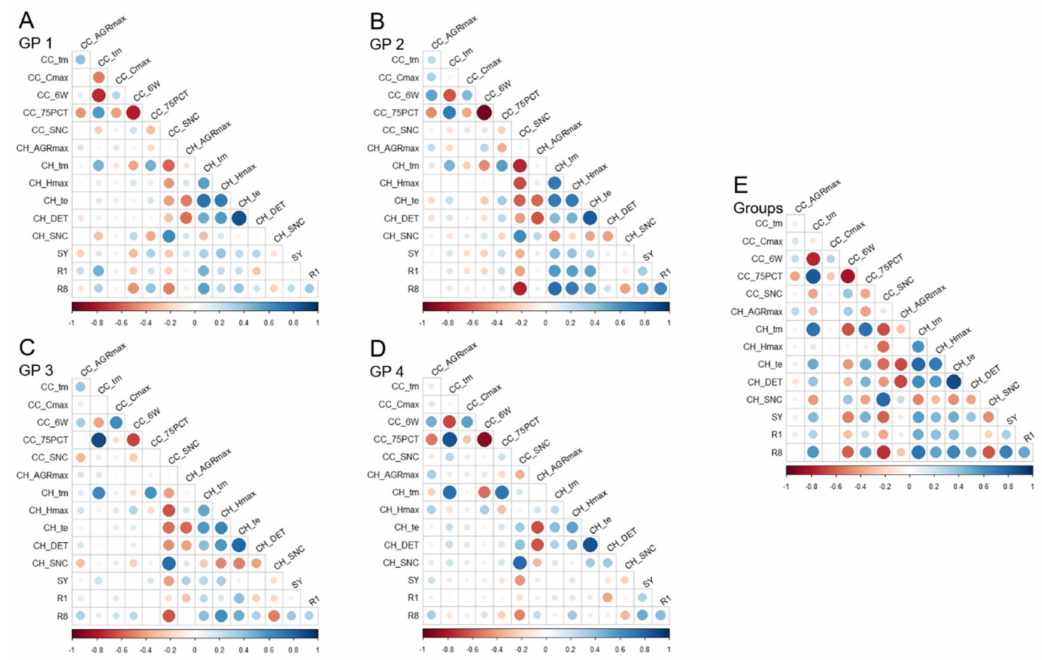
Figure 7. Correlograms between the UAV derived phenotypic parameters and field observations per group ( a – d , GP1-4) and grouped ( e ) (n = 148). For the abbreviations, see Table